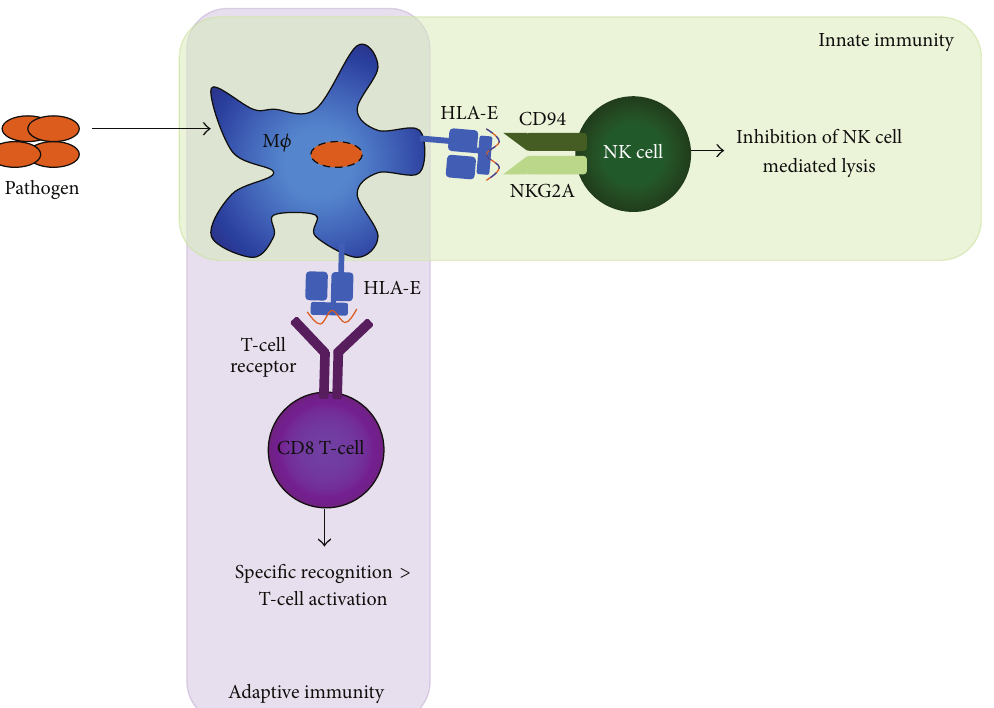
Figure 1: HLA-E serves a dual role in the immune system. HLA-E presents antigens, including pathogen-derived antigens on the cell surface of most cells. NK cells, as part of the innate immune system, will sense the presence of HLA-E presenting self or pathogen-derived peptides and thereby receive inhibitory signals from the CD94/NKG2A complex such that NK mediated lysis will be inhibited. In addition, CD8 + T-cells may specifically recognize foreign peptide presented by HLA-E and become activated through their T-cell receptor, resulting in T-cell activation, expansion, and memory formation in the adaptive immune